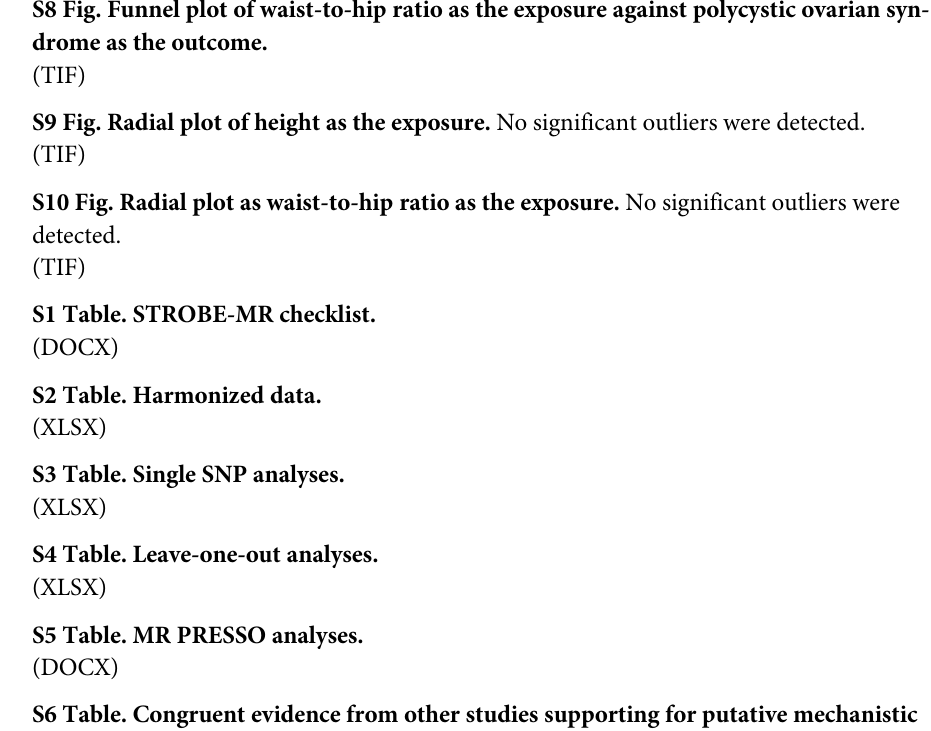
S5 Table. MR PRESSO analyses. S6 Table. Congruent evidence from other studies supporting for putative mechanistic roles of the shared and non-shared genes underlying the causal associations between anthropometric markers of central—and/or general obesity and